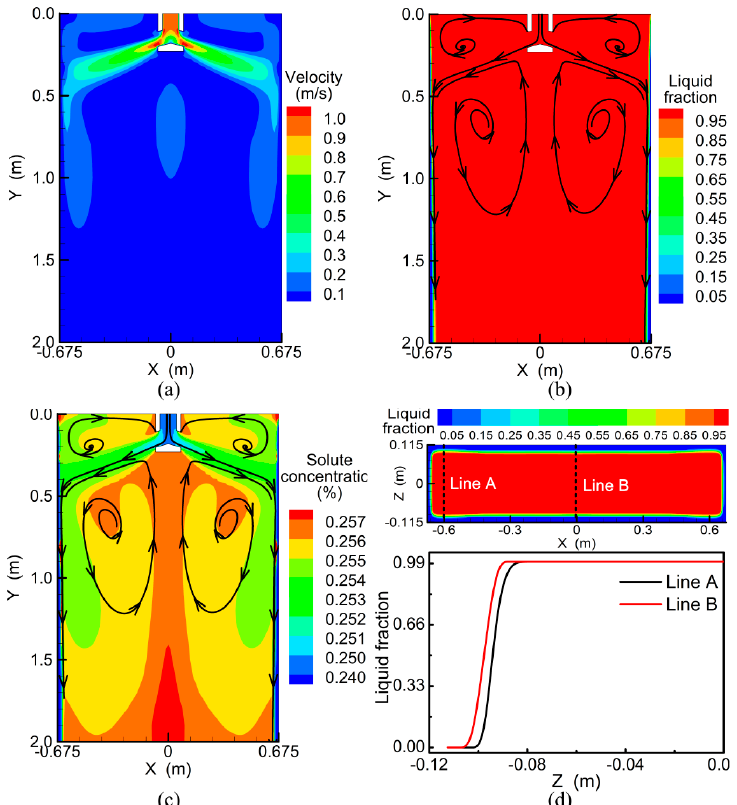
Figure 5. Fluid flow ( a ), liquid fraction ( b ), and solute concentration distribution ( c ) in the mold zone, and the liquid fraction at the mold exit ( d ).